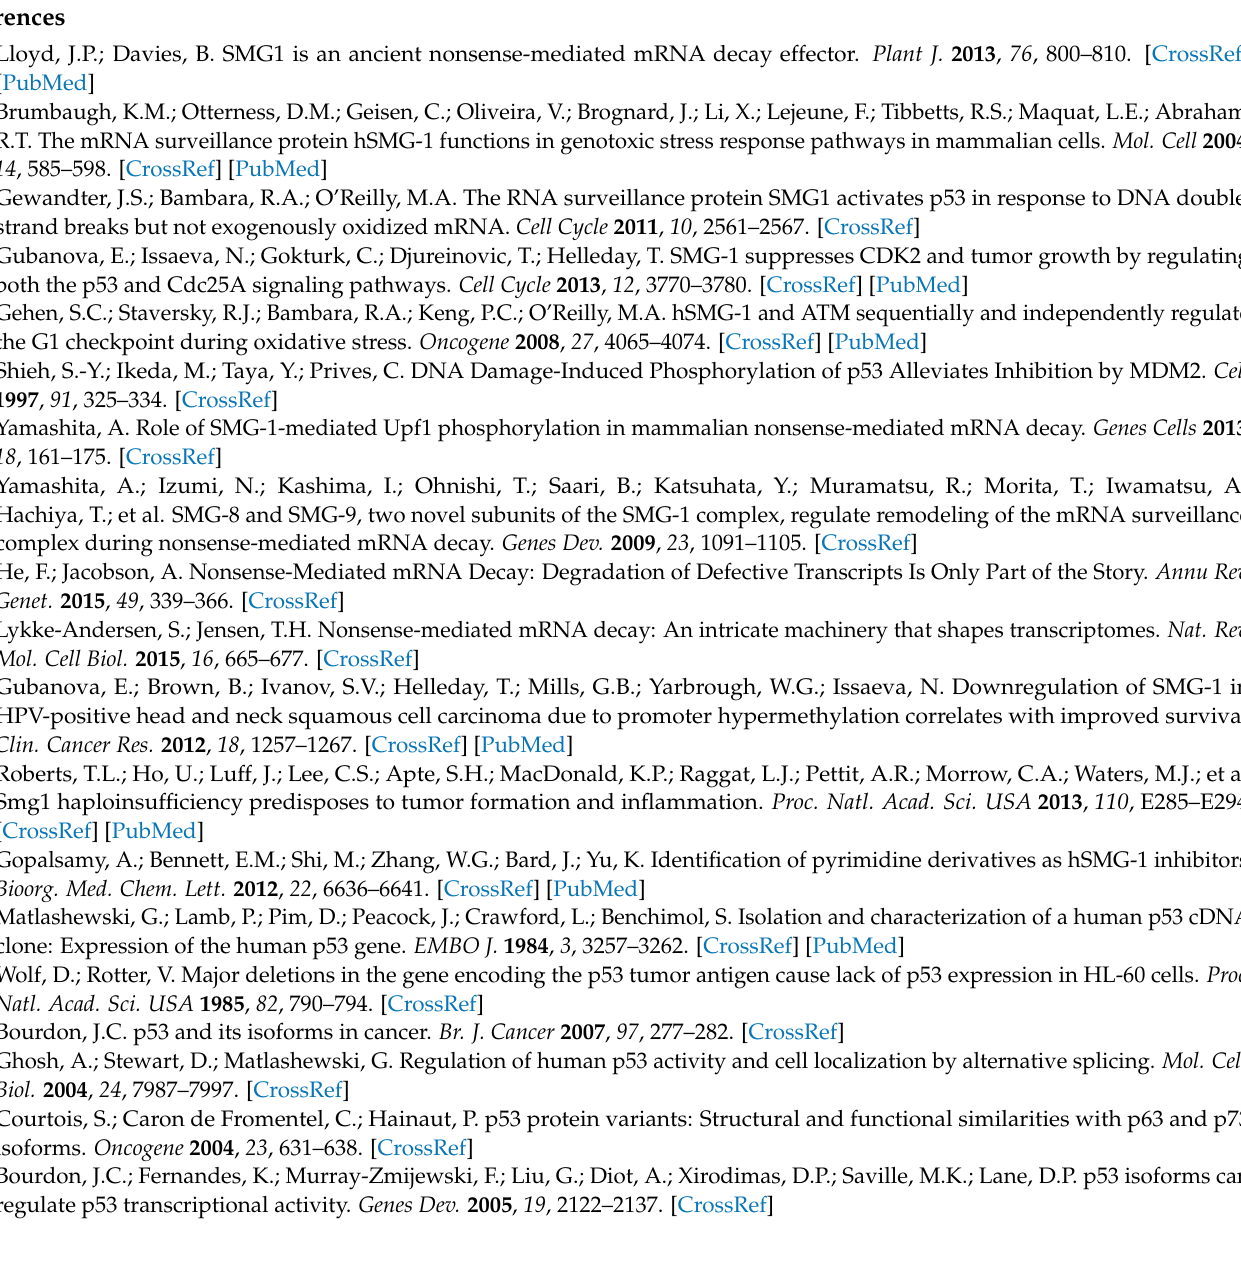
Figure A5. Representative RT-PCR results for SMG1, ABCA1 and miR-33a-5p expression levels in RNA collected from MCF7 cells from a single triplicated experiment 48- and 72-h post-transfection. Error bars represent Mean ± SD. For all RT-PCR studies, individual samples are run in triplicate.